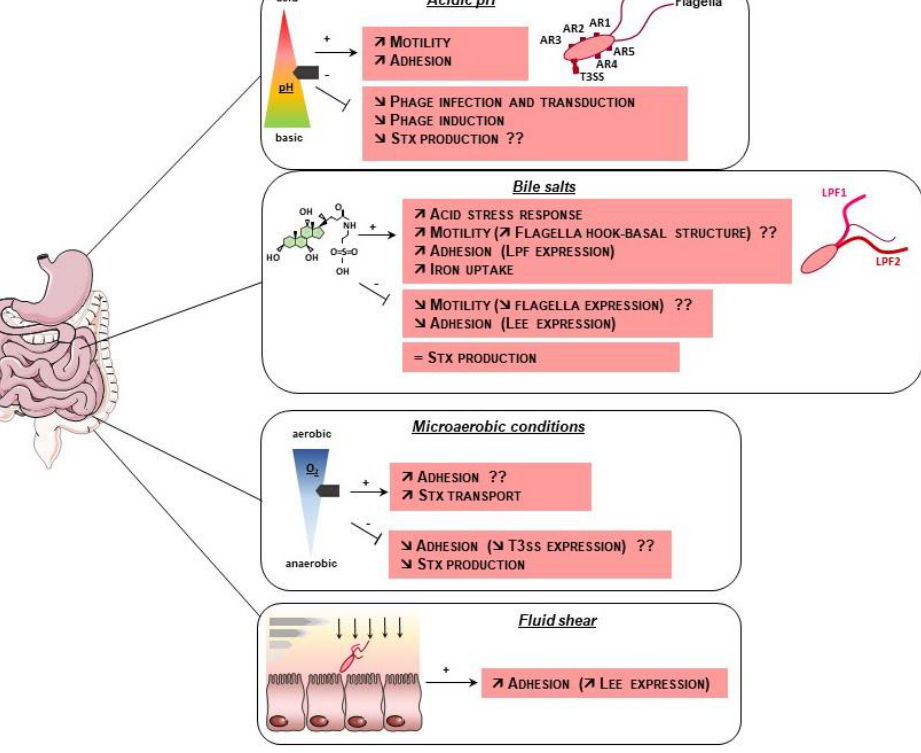
Figure 2. Influence of abiotic factors on EHEC virulence. EHEC has the ability to resist the stressful conditions encountered in the gut such as acidic pH and bile salts and utilizes various abiotic GI cues to modulate the expression of its virulence factors. Stx: Shiga-toxins, LPF: Long Polar Fimbriae, LEE: Locus of Enterocytes Effacement, T3SS: Type III secretion system, AR: Acid resistance, arrow with the sign + represents an activation process, bolded line with the sign − represents repression, ?? indicates contradictory results.